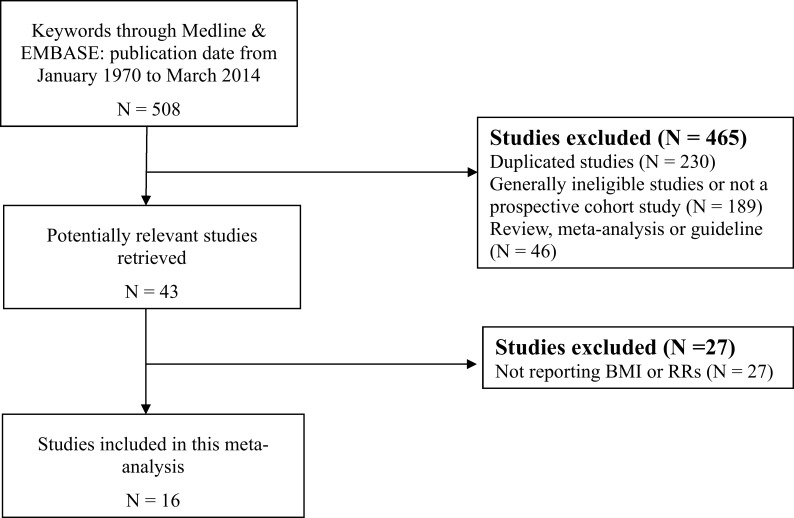
Flow diagram of the selection process for this meta-analysis.Details of the selection process are presented.